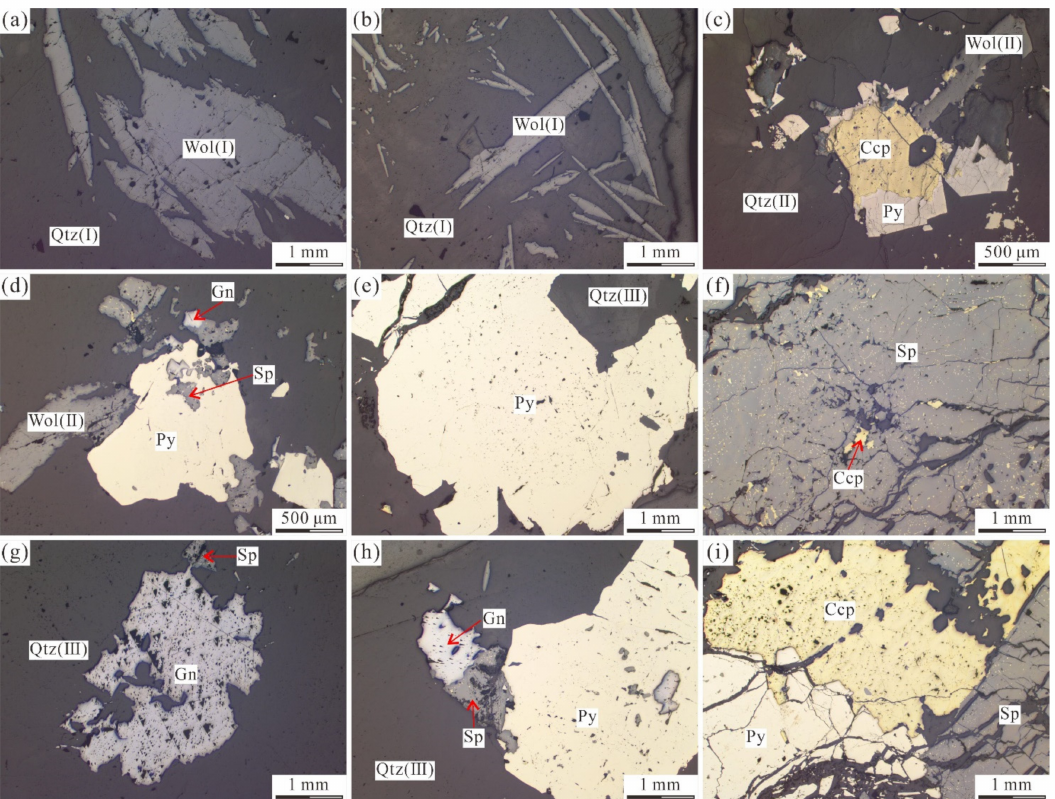
Figure 5. Representative photomicrographs of ore minerals from the Baishitouwa deposit. ( a ) Wol- framite (I) intergrown with fine-grained quartz (<1 mm) of stage 1; ( b ) Wolframite (I) crystals occur as long columnar and needle columnar from stage 1; ( c ) Wolframite (II) coexisting with pyrite and chalcopyrite; ( d ) Wolframite (II) intergrown with pyrite of stage 2. Pyrite replaced by galena and sphalerite of stage 3 along fractures and crystal margins; ( e ) Medium-grained euhedral pyrite from stage 3; ( f ) The exsolution texture of sphalerite–chalcopyrite solid solution. Late generation of chal- copyrite replacing sphalerite along the fissure and margin; ( g ) Medium-grained anhedral galena and sphalerite intergrown with quartz from stage 3; ( h ) Sphalerite replacing pyrite along crystal margin, and galena replacing sphalerite and pyrite; ( i ) Late generation of chalcopyrite replacing pyrite and sphalerite along fractures and crystal margins. Abbreviations: Qtz, quartz; Wol (I), early generation of wolframite; Wol (II), late generation of wolframite; Py, pyrite; Ccp, chalcopyrite; Gn, galena; Sp,